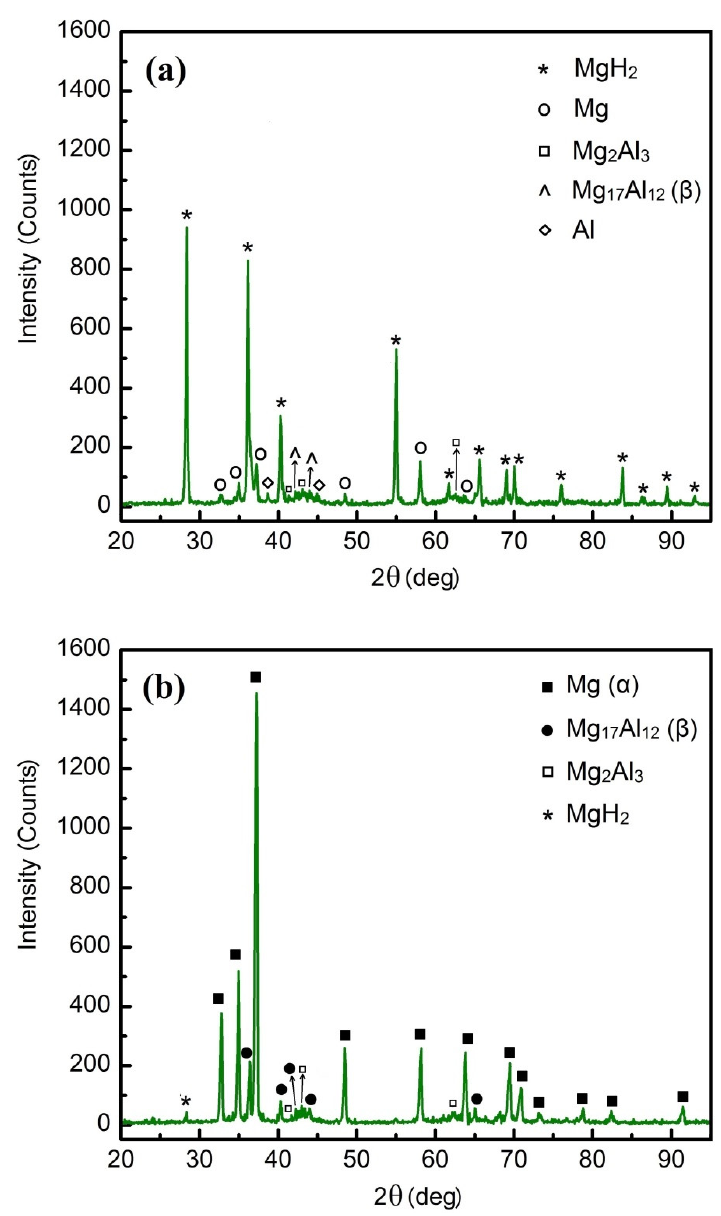
Figure 4. XRD diffraction patterns for S4 sample (second pass of TPCAE at 200 °C): ( a ) after hydro- genation; ( b ) after dehydrogenation.